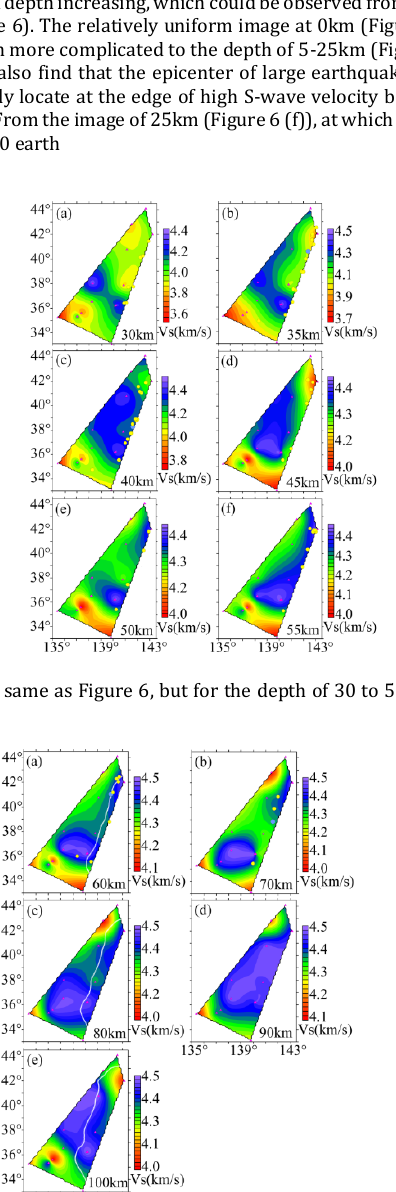
Figure 6: The obtained S-wave velocity distribution at different depth (0 to 25km with 5km interval). Red and blue colors represent low and high velocities, respectively. The absolute velocity value is shown at right. The purple triangles denote stations. The yellow circles, blue circles and the red star represent epicenters of earthquakes above Mw6.0, Mw6.5 and Mw7.0, respectively.